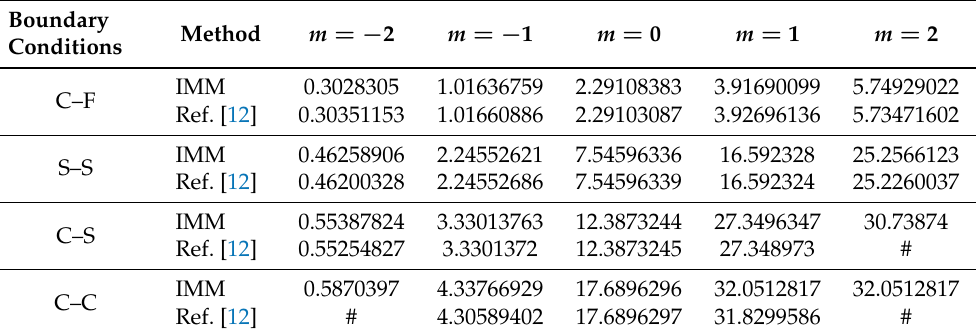
Table 8. The variations of dimensionless critical load for a Timoshenko beam with the gradient parameter m ( n =